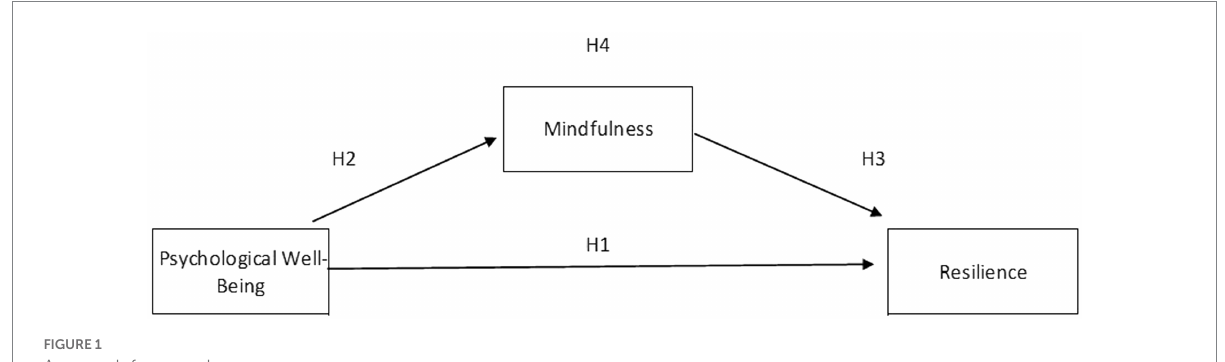
FIGURE 1 A research